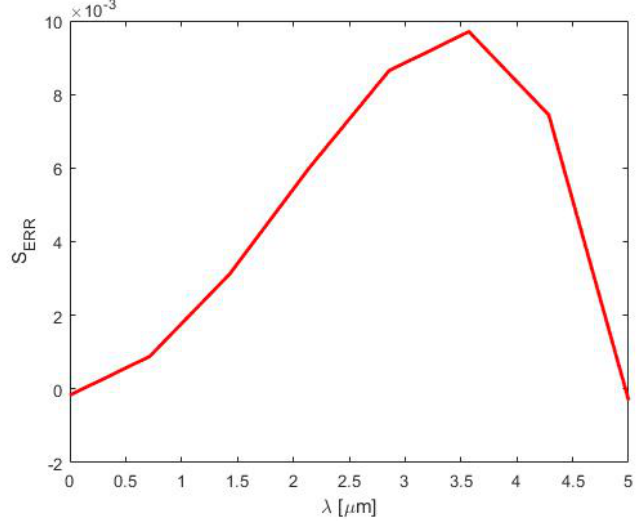
Figure A5. The difference between the spectral response with 1% error in the voltage and without it using Laguerre